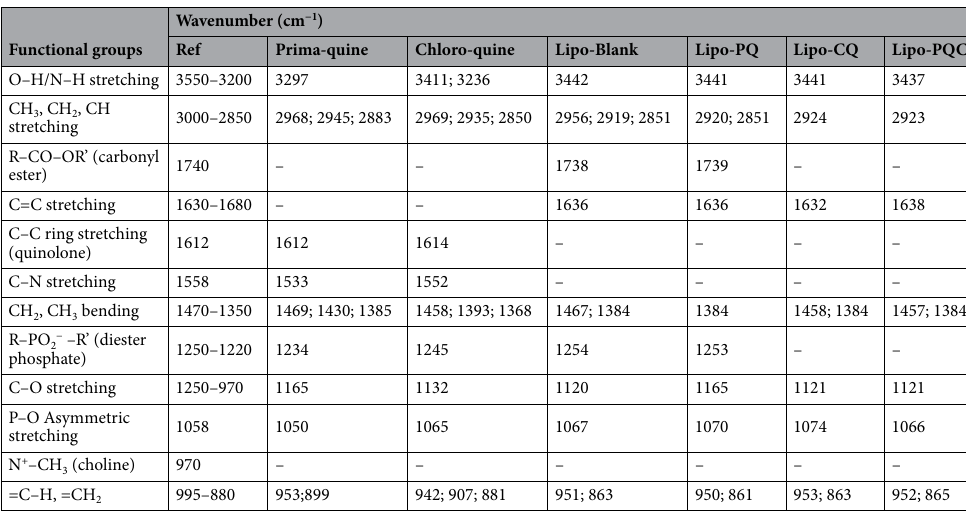
Table 2. The peak absorbance value of the infrared spectra of free primaquine (PQ), free chloroquine (CQ), blank liposomes (Lipo-Blank), primaquine-loaded liposomes (Lipo-PQ), chloroquine-loaded liposomes (Lipo-CQ), and liposome co-loaded with primaquine and chloroquine (Lipo-PQCQ).